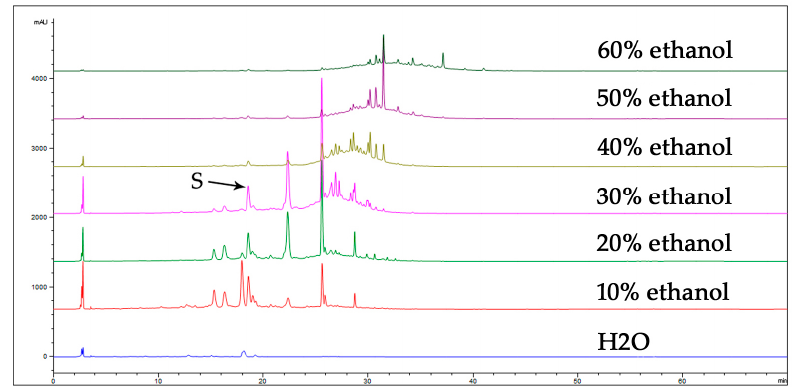
Figure 3. HPLC chromatograph of eluents eluted with H 2 O and ethanol of different concentrations on a macroporous resin. The chromatographic conditions were the same as those described in the HPLC fingerprint.